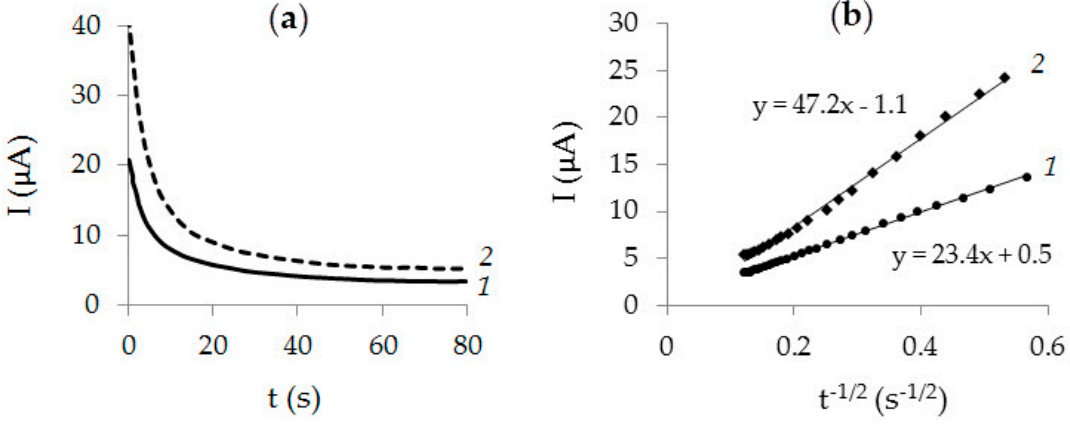
Figure 5. Chronoamperograms obtained on CVE ( 1 ) and Au-gr/CVE ( 2 ) in 1.0 mM K 4 [Fe(CN) 6 ] + 0.1 M KCl, E = 0.7 V ( a ). Dependencies I = f ( t − 1 / 2 ) are obtained from chronoamperograms on the corresponding electrodes ( b ).